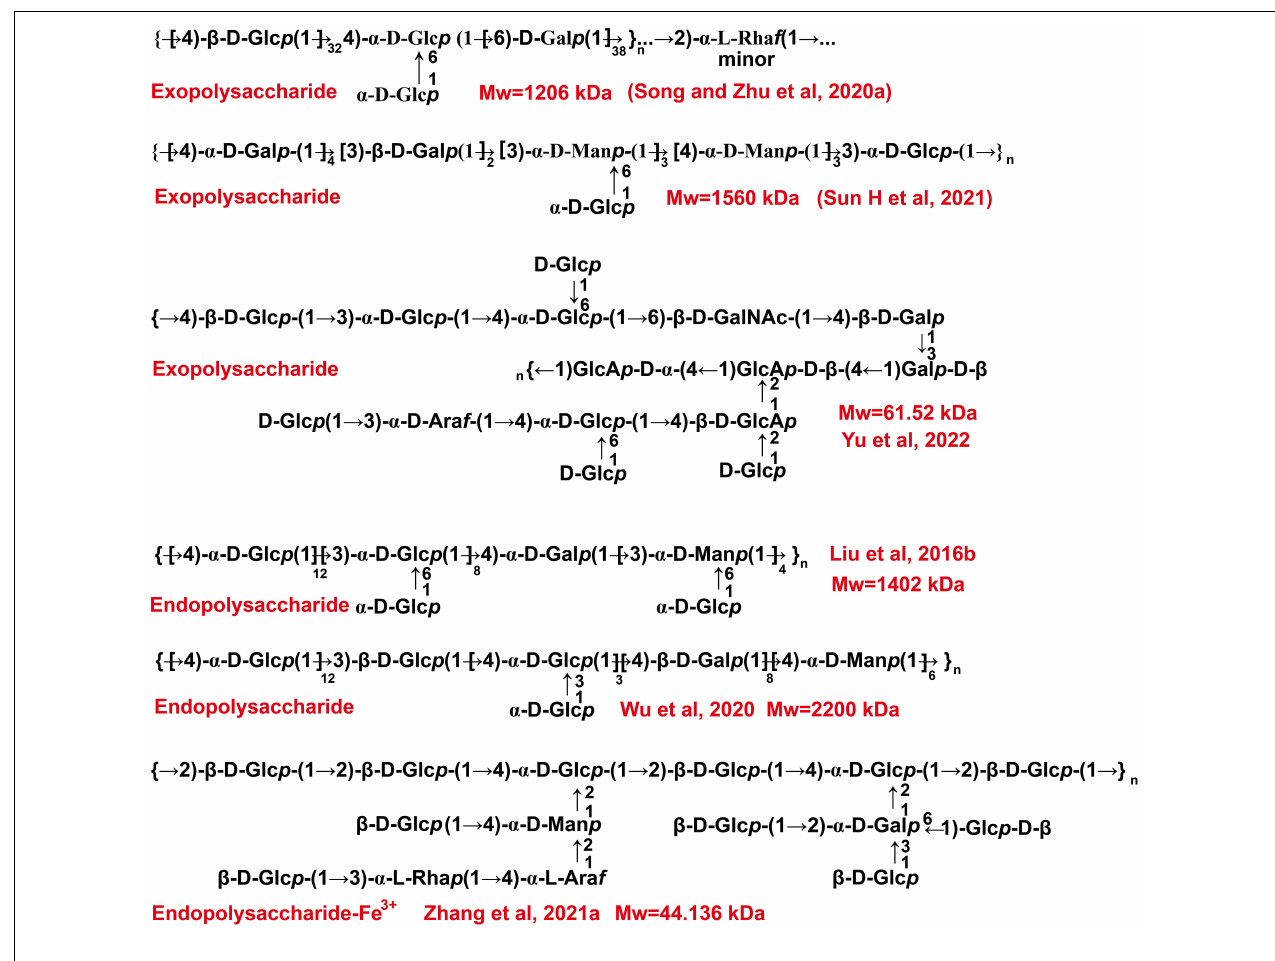
FIGURE 5 | The presumed chemical structures of polysaccharides derived from the fermentation broth of C. militaris